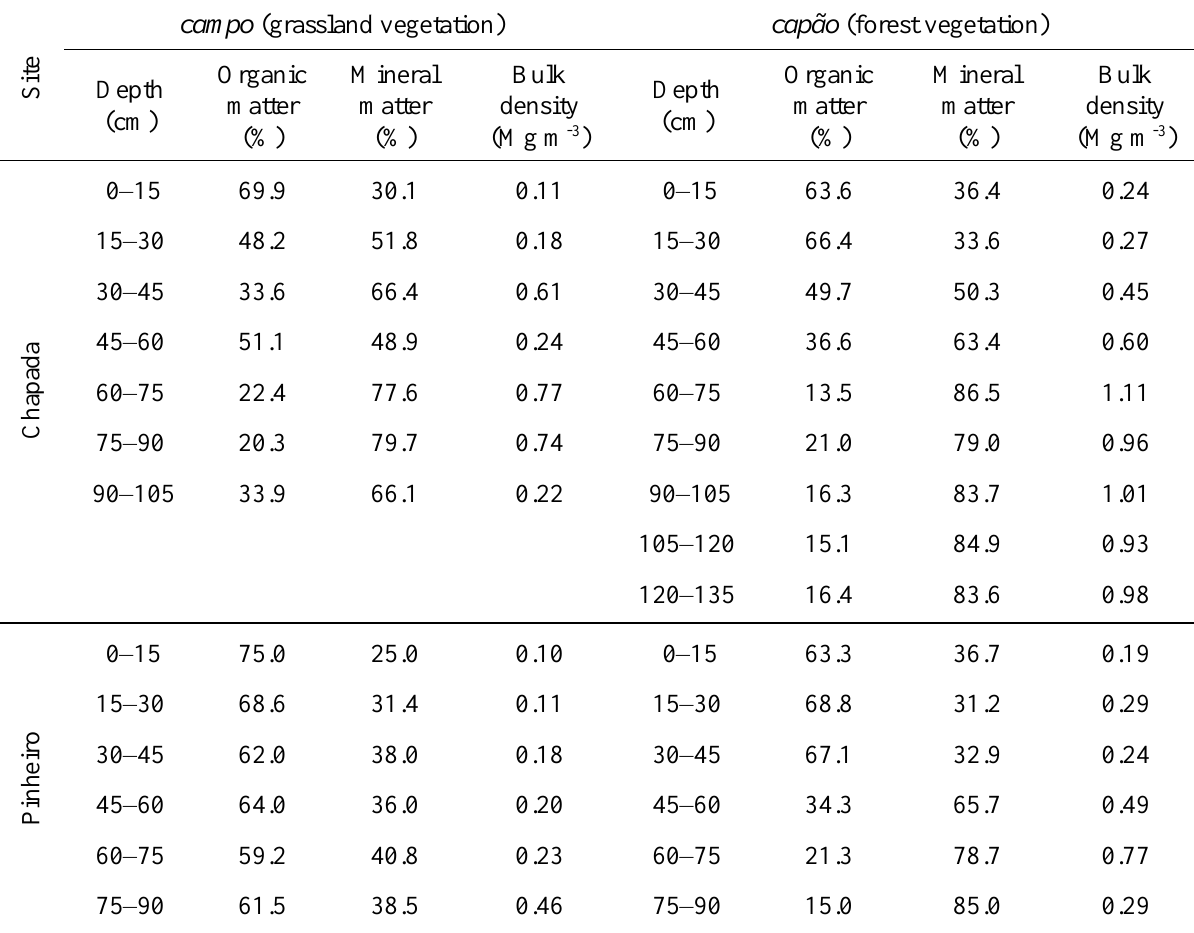
Table 1. Organic and mineral matter content (loss on ignition) and bulk density for the evaluated depths of the Chapada and Pinheiro peatlands under campo (grassland) and capão (forest).